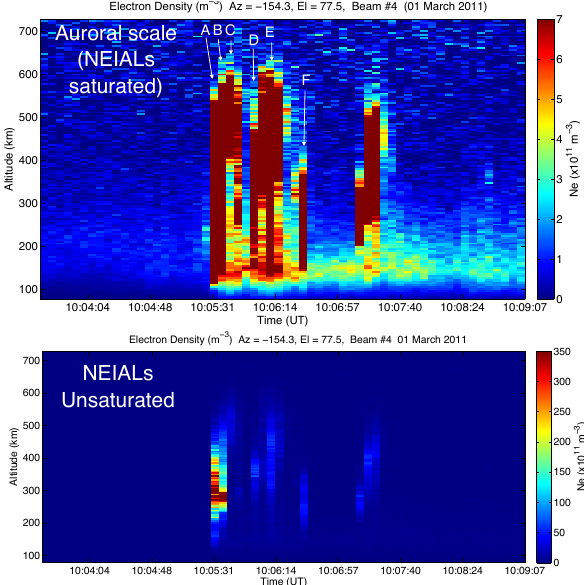
Figure 1. Event 1: top: PFISR electron density profiles, covering a time period of about 6min around substorm onset. The strong NEIAL returns can be seen to extend from 120km up to 600km altitude. The times marked A–F are the times of the NEIAL spectra shown in Fig. 2. Bottom: same time period with intensity scale set so the NEIALs are not